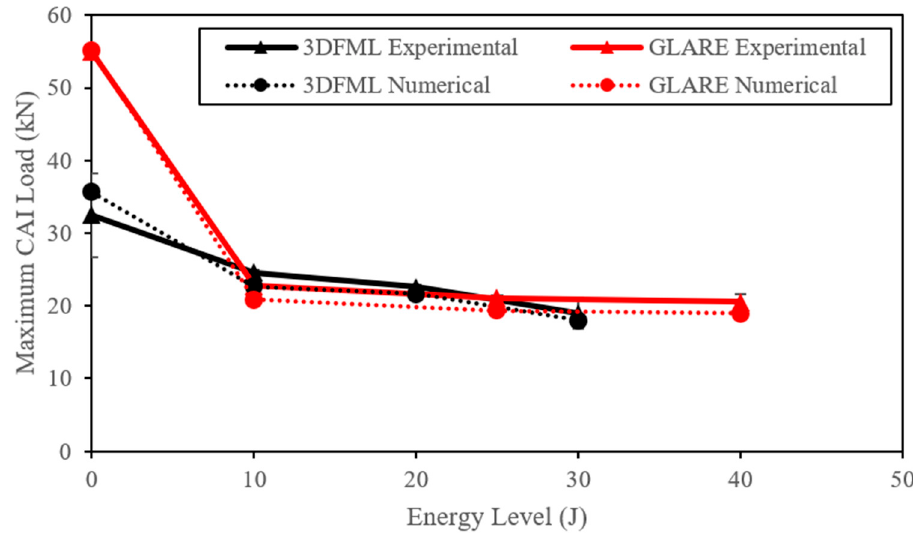
Figure 20. Comparison of the experimental and numerically predicted compressive strengths of virgin and impacted 3DFML and GLARE specimens as a function of impact energy.